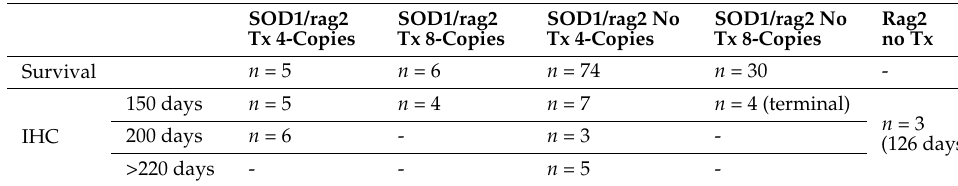
Table 2. Animal distribution within experimental